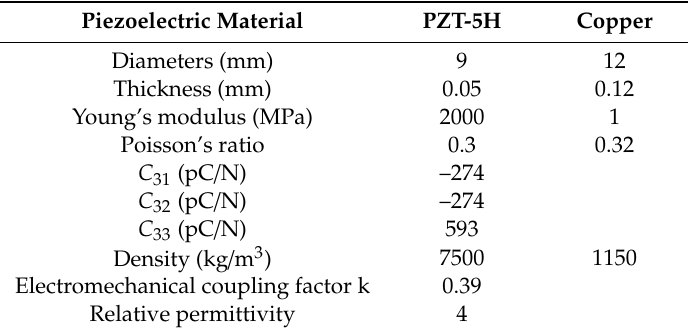
Table 2. Material parameters of the